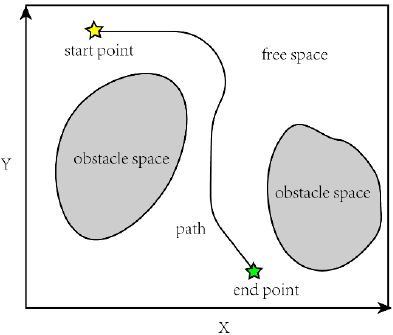
Figure 8. Schematic of a two-dimensional C-space.